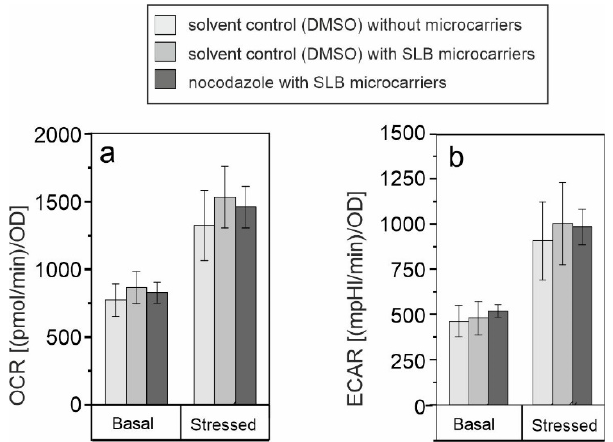
Figure 8. Extracellular flux analysis with the cell energy phenotype test kit was performed to measure basal and stressed ( a ) OCR (mitochondrial respiration) and ( b ) ECAR (glycolysis) in Vero cells under the shown conditions. Measurements were normalized to total protein content. (n = 3, one-way ANOVA with Tukey’s post-hoc, significance versus the control (Vero in the solvent control and in the absence of microcarriers).